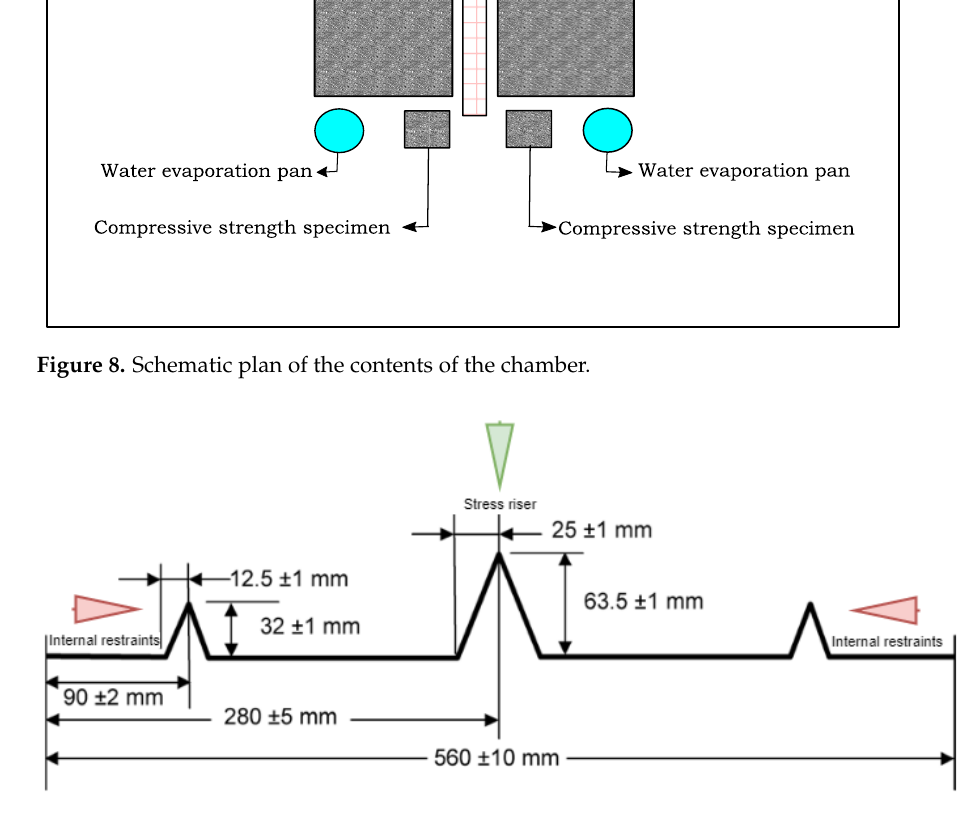
Figure 9. Geometry of the stress riser and internal restraints. Figure 10. The complete mould. Figure 10. The complete mould.